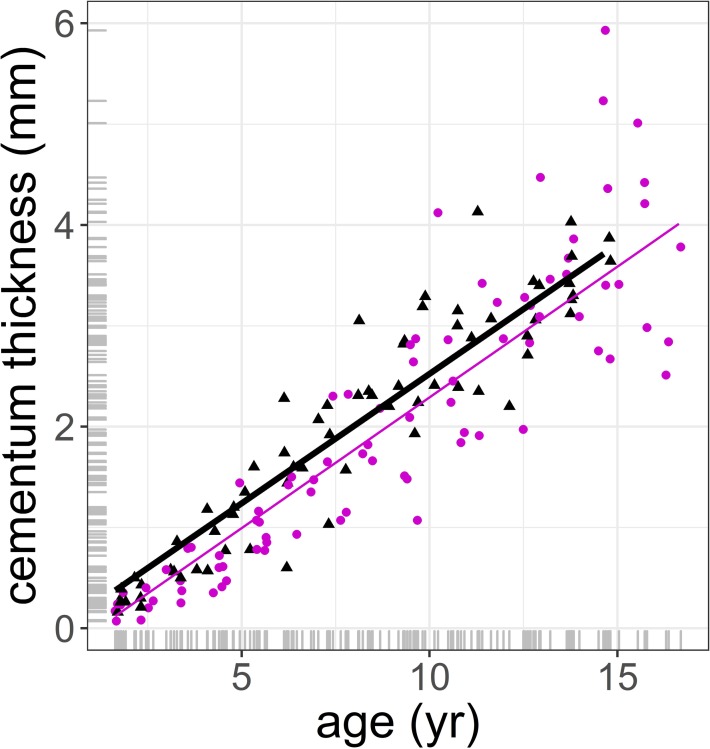
Prediction of inter-radicular cementum thickness pad (in mm) against age (in years) using the model in Table 4.Circle and purple thin line: female; triangle and black thick line: male. No significant differences in slope and intercept between sexes. The marginal distribution of x and y variables are displayed as grey ticks along the axes.